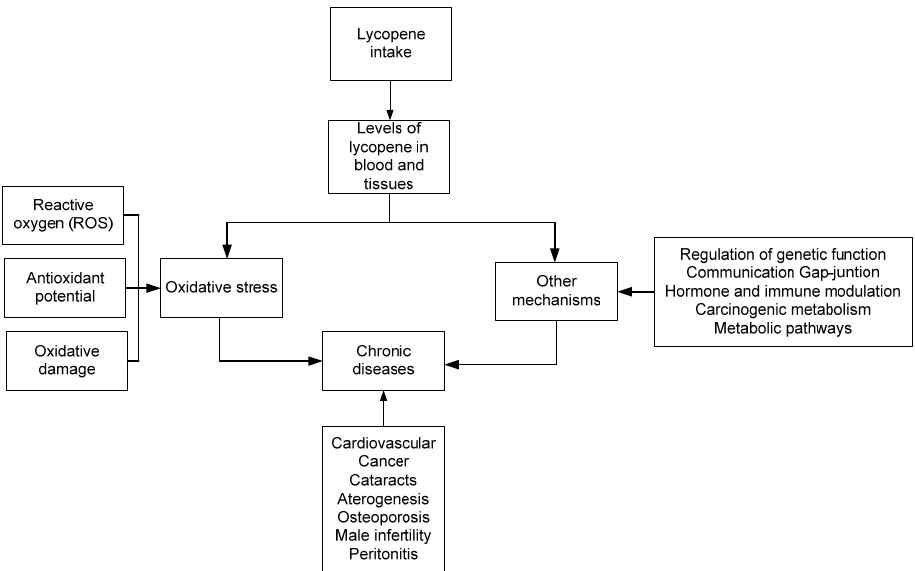
Figure 2. Role of lycopene in the prevention of chronic diseases [20].